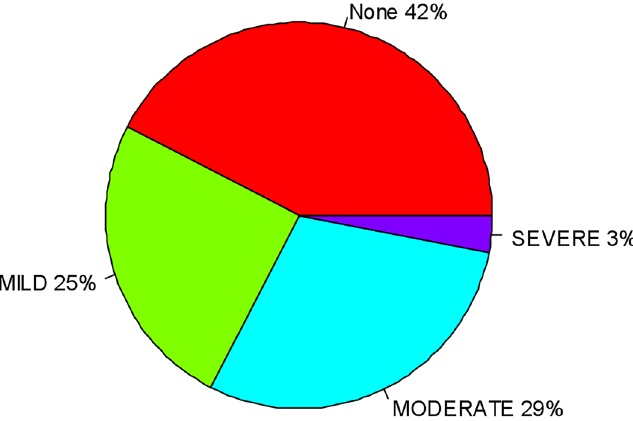
Figure 1. Prevalence of anemia among children aged from 6 to 59 months in Ethiopia,